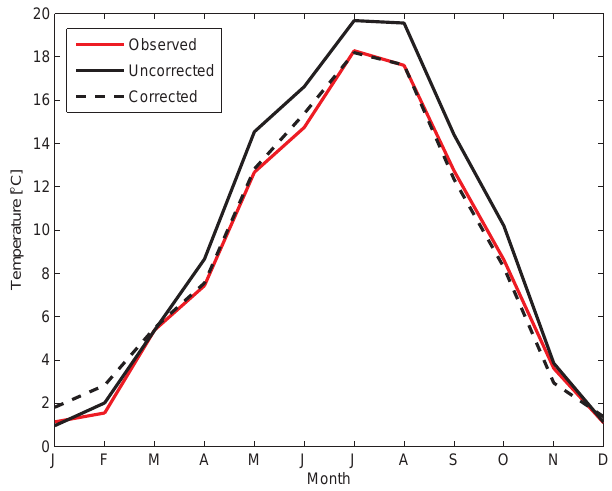
Fig. 17. Area-weighted monthly temperature [ ◦ C] over the en- tire Rhine basin for the validation period 1989-1995. Results are shown for the observations and the uncorrected and corrected